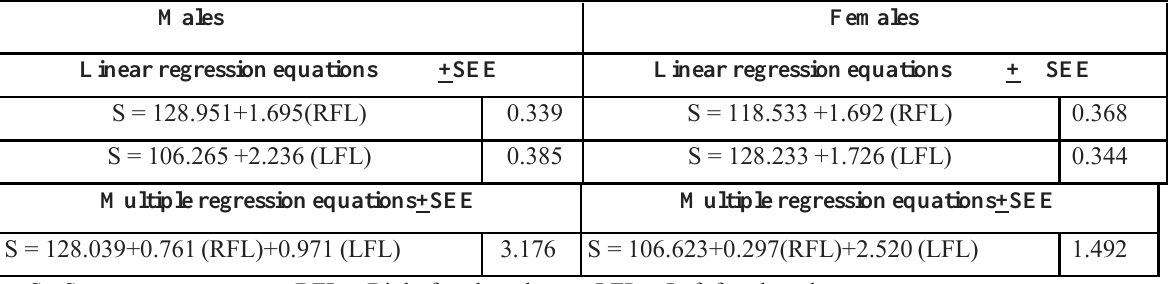
Table 3. Linear and multiple regression equation for estimation of stature (cm) from measurement of